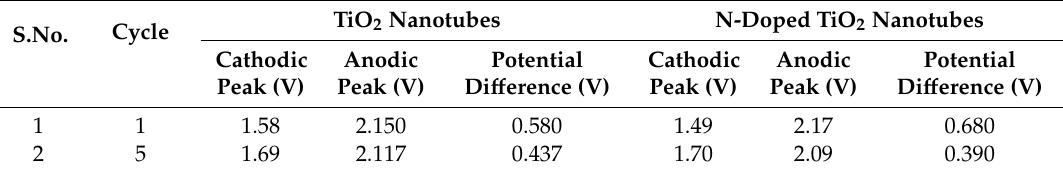
Table 3. The peak position of cathodic, anodic, potential di ff erence of TiO 2 nanotubes and N-TiO 2 nanotubes electrodes.